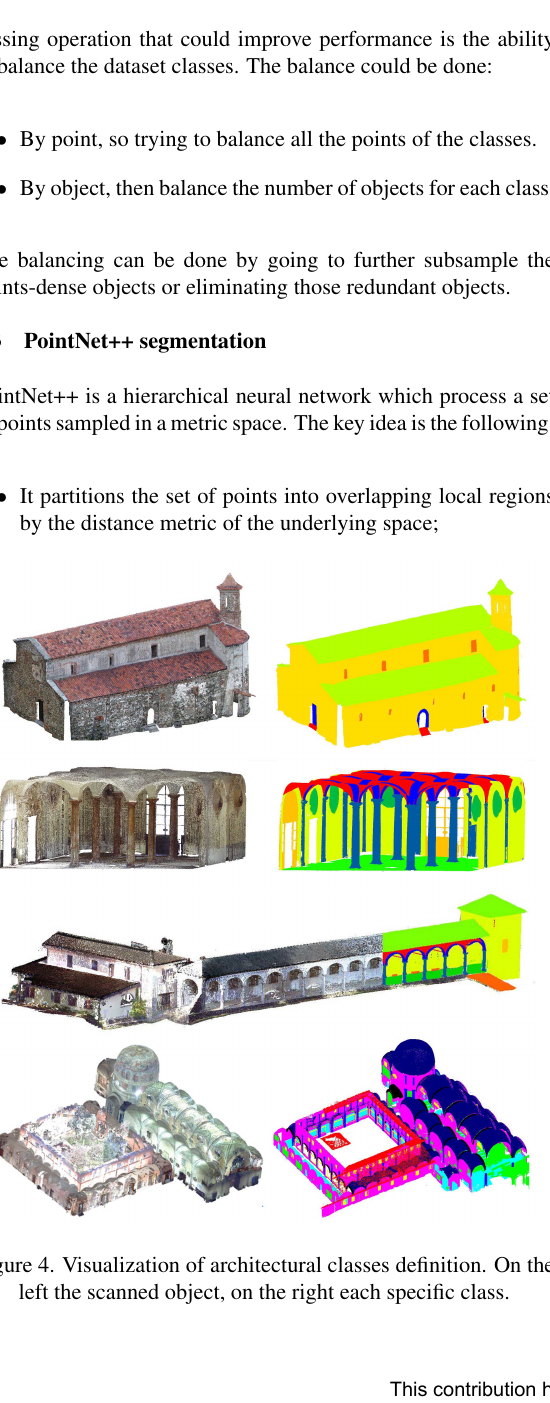
Figure 3. General schema of the unified method for the architectural element definition and classification.